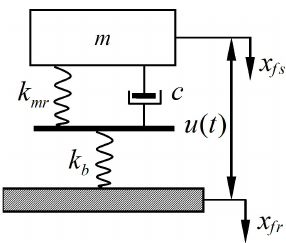
Figure 5. Dynamical model of the satellite and rocket